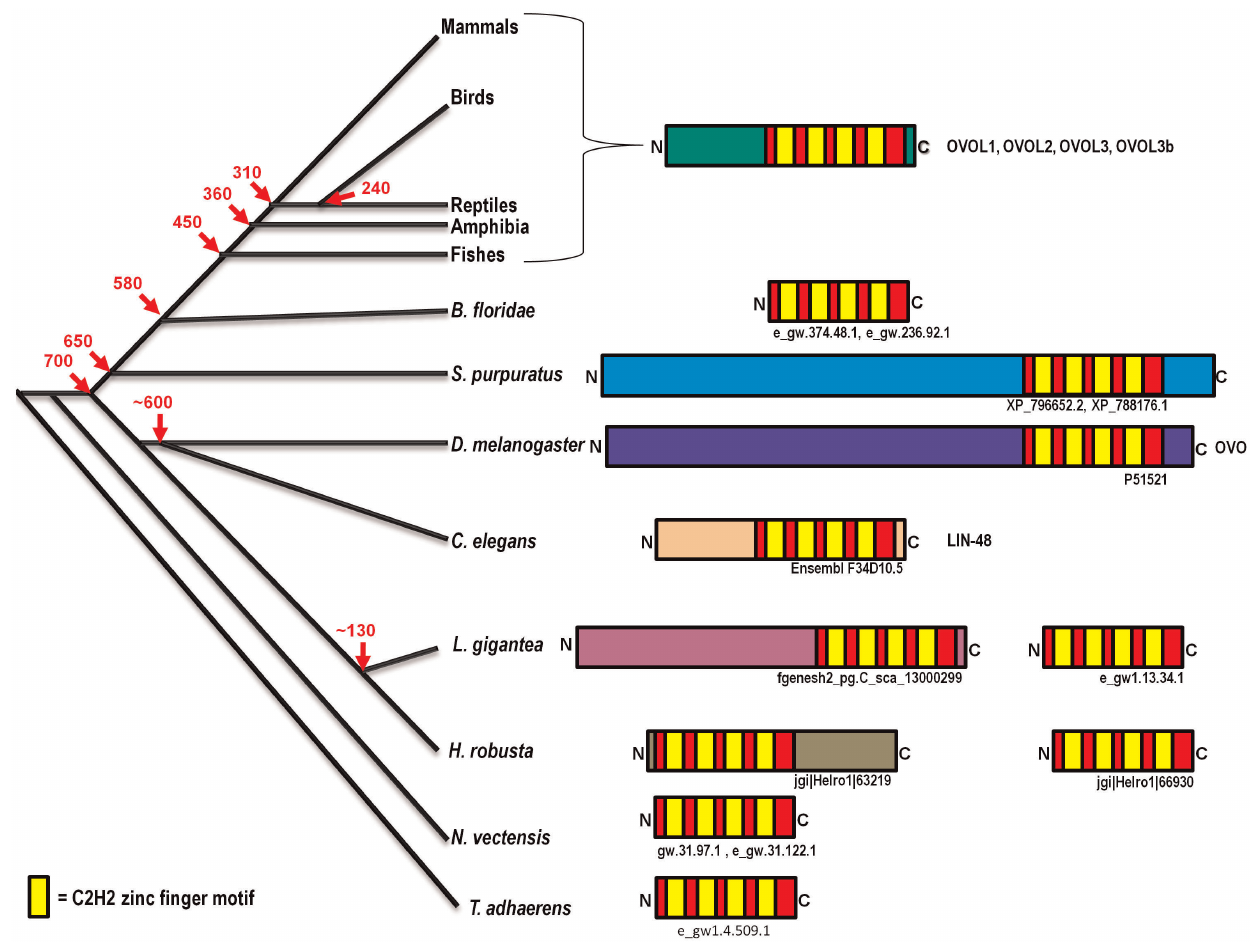
Figure 8. Protein domain evolution of OVOL proteins from different metazoan lineages over a period of . 700 MY. A highly conserved domain of a tetrad of C2H2 zinc finger motifs (red and yellow box) is found in various metazoa. Primarily, the N-terminal extensions in C2H2 lead to different types of protein with the exceptions of OVOL proteins from the leech and sea urchin where extension was found in the C-terminal end of C2H2 zinc finger motif. The ID segments with no homology in evolutionary distant organisms are marked in different colors. Times of divergence are taken from Kumar and Hedge (2003) [82] and Ponting (2008) [83].